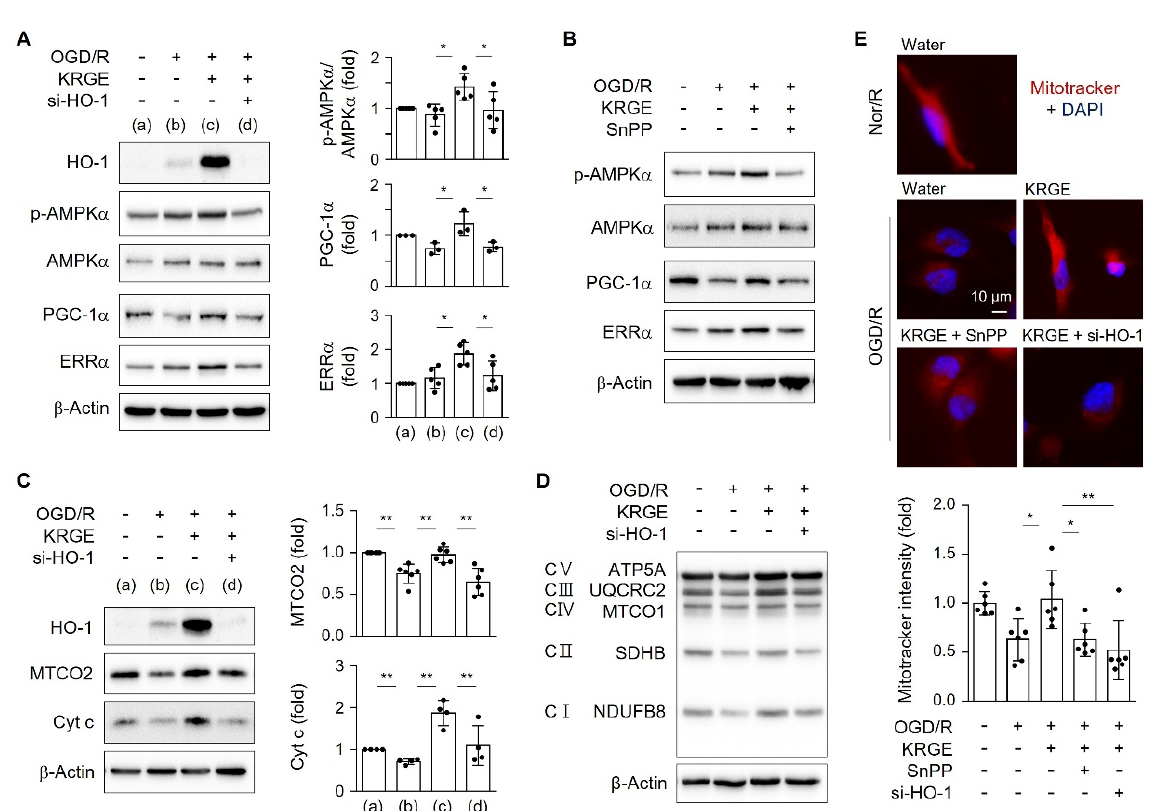
Figure 3. KRGE-mediated HO-1 expression enhanced mitochondrial functional regulating proteins. ( A ) Human astrocytes were transfected with 50 nM siRNAs as the control or HO-1 (si-HO-1) and subjected to OGD/R followed by treatment with 250 μ g/mL KRGE. Target protein levels in lysed cells were detected via Western blotting. ( B ) Astrocytes were subjected to OGD/R and co-treated with 25 μ M Sn(IV) protoporphyrin IX dichloride (SnPP) and 250 μ g/mL KRGE for 24 h. Target protein levels in lysed cells were detected via Western blotting ( n = 3). ( C ) Under same ( A ) conditions, cytochrome c oxidase subunit 2 (MTCO2) ( n = 6) and Cyt c ( n = 4) were detected via Western blotting. ( D ) Oxidative phosphorylation (OXPHOS) complexes (C I–IV) and ATP synthase (ATP5A) (C V) were demonstrated via Western blotting ( n = 3). ( E ) Representative image of the Mitotracker (red) and DAPI (blue) staining in human astrocytes ( n = 6 per group). Scale bar = 10 µ m. * p < 0.05; ** p < 0.01.